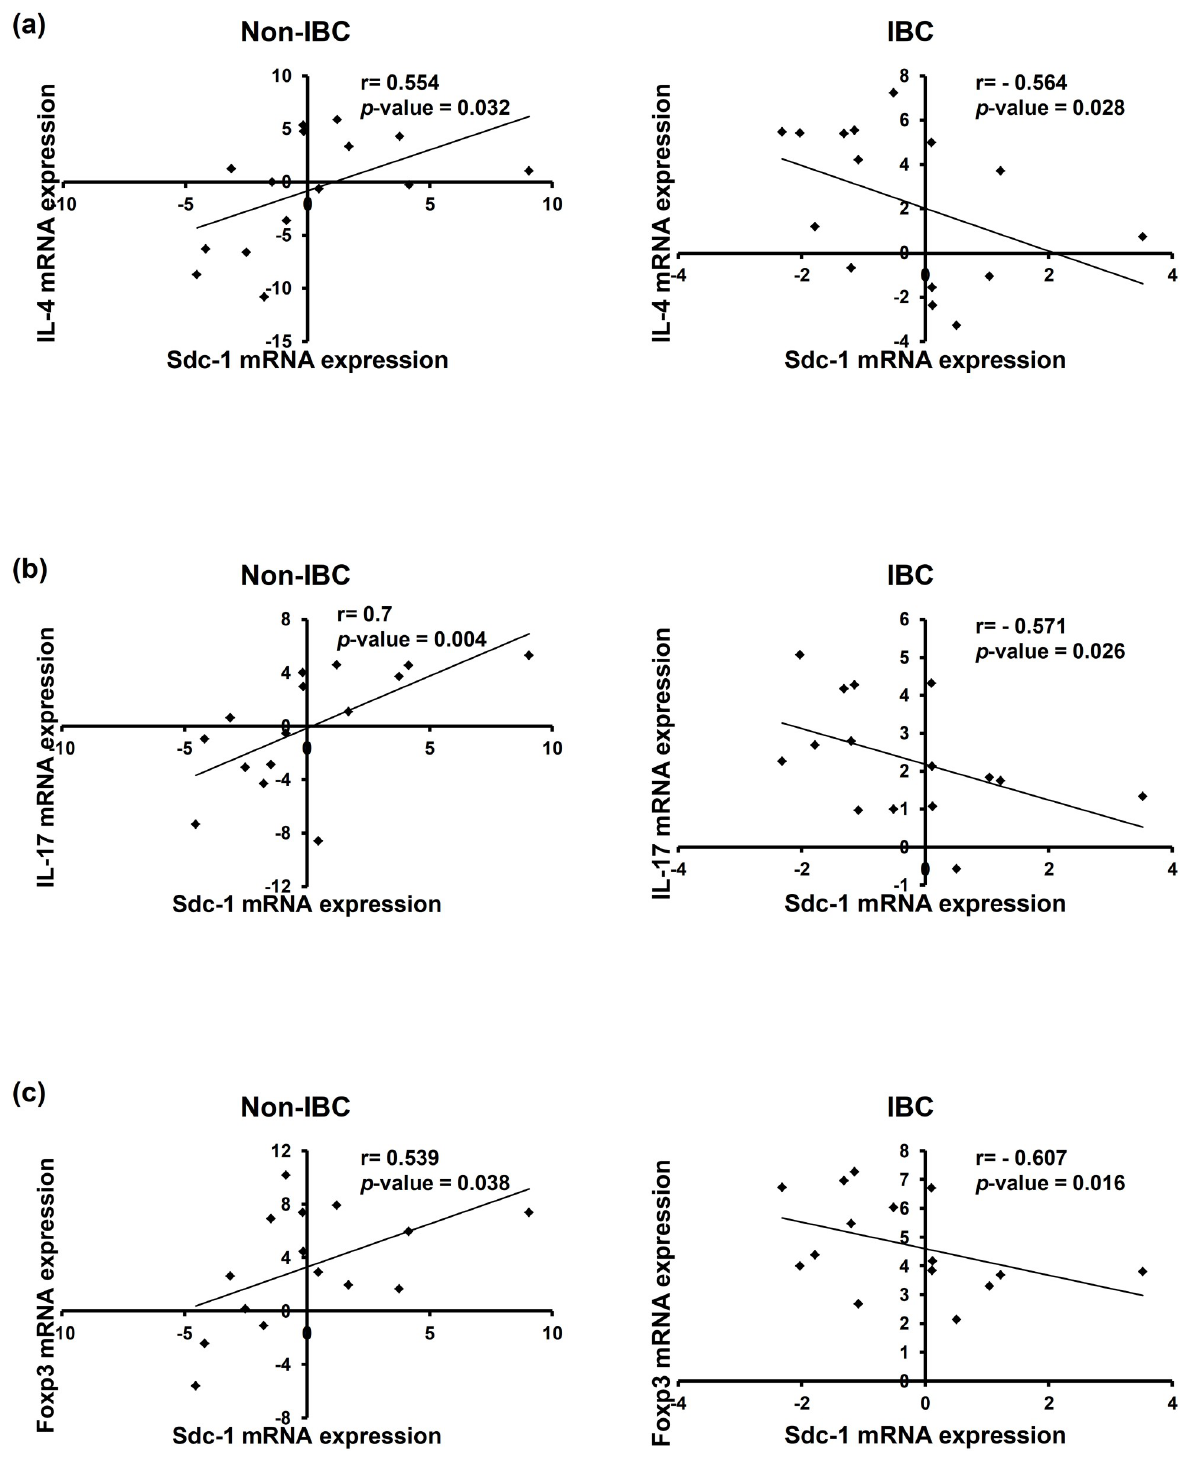
Fig 4. Spearman’s correlation between expression of Sdc-1 and each of IL-4, IL-17, and Foxp3 mRNA levels in carcinoma tissue of non-IBC and IBC patients. Total RNA was extracted from non-IBC and IBC carcinoma tissues collected during surgical operation, reverse transcribed into cDNA, and relative mRNA expression of Sdc-1, IL-4, IL-17, and Foxp3 was determined by qPCR. Spearman‘s rank correlation between Sdc-1 and a) IL-4, b) IL-17, and c) Foxp3 mRNA expression in carcinoma tissue of non-IBC (n = 15, positive correlation, left panel) vs. IBC patients (n = 15, negative correlation, right panel). RQ values of mRNA expression are log2-transformed and normalized to values of normal tissues collected during reduction mammoplasty.